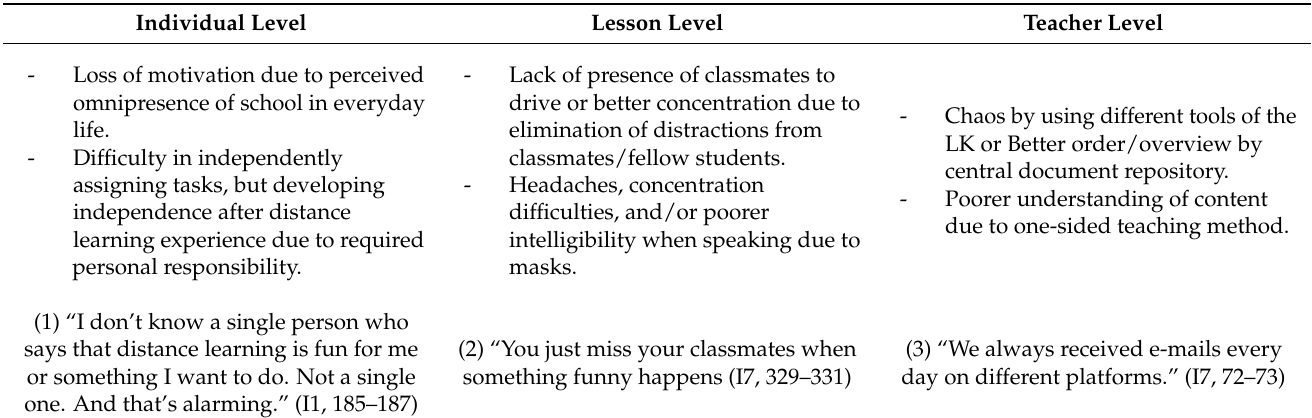
Table 4. Inductive coding: findings on the area of